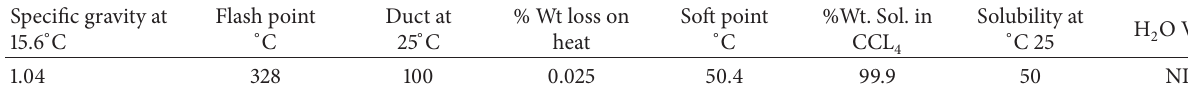
Table 1: Physical properties of Iraqi asphalt (as received from supplier).